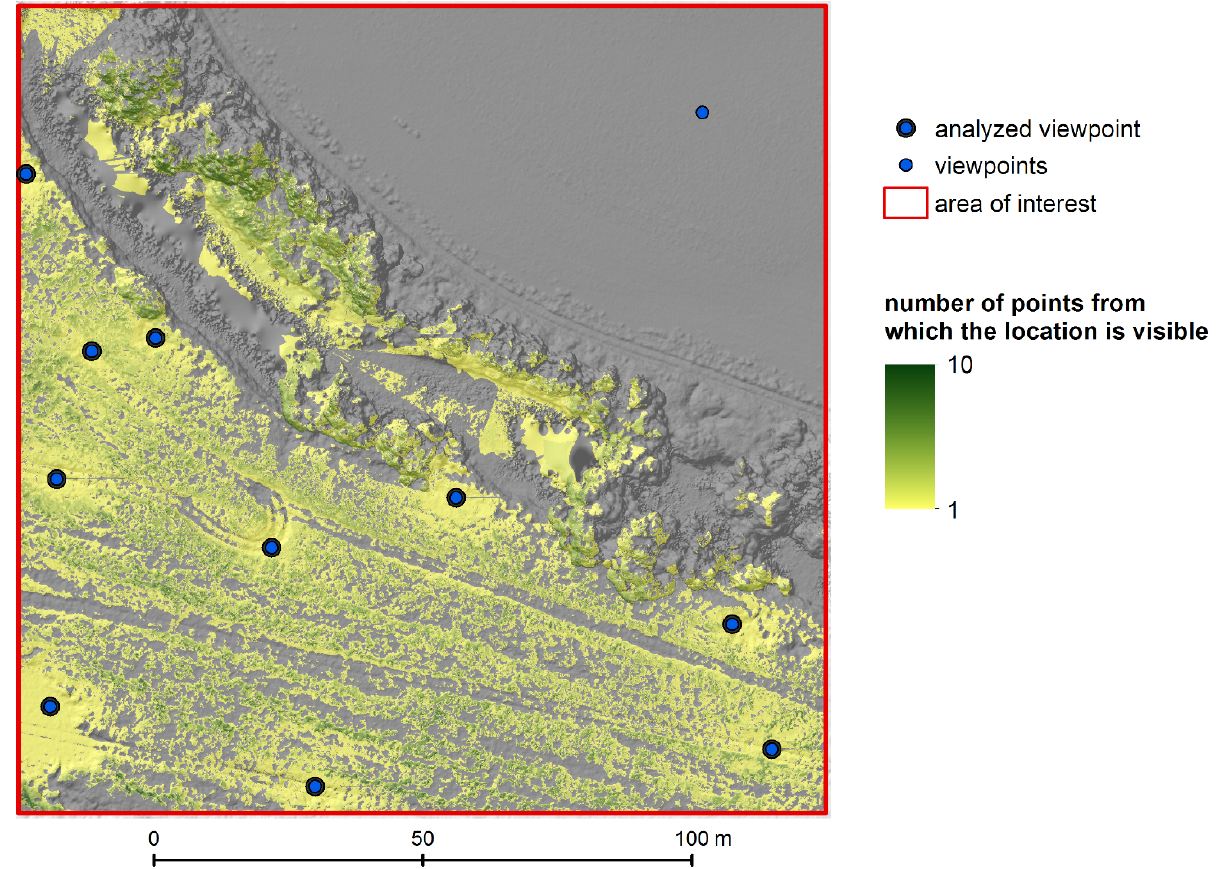
Figure 5. Multiple viewshed from the points in southern part of the area of